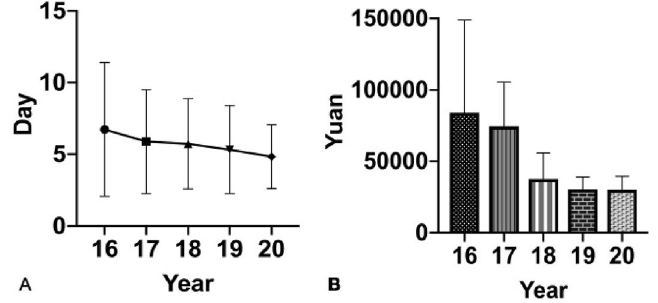
Figure 3. ( A ) Hospital stay and ( B ) hospital cost.